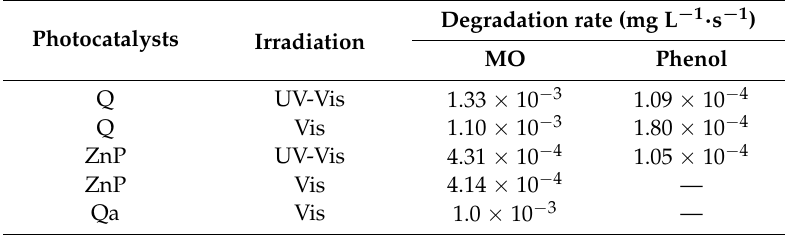
Table 2. Phenol and methyl orange (MO) degradation rate under different light